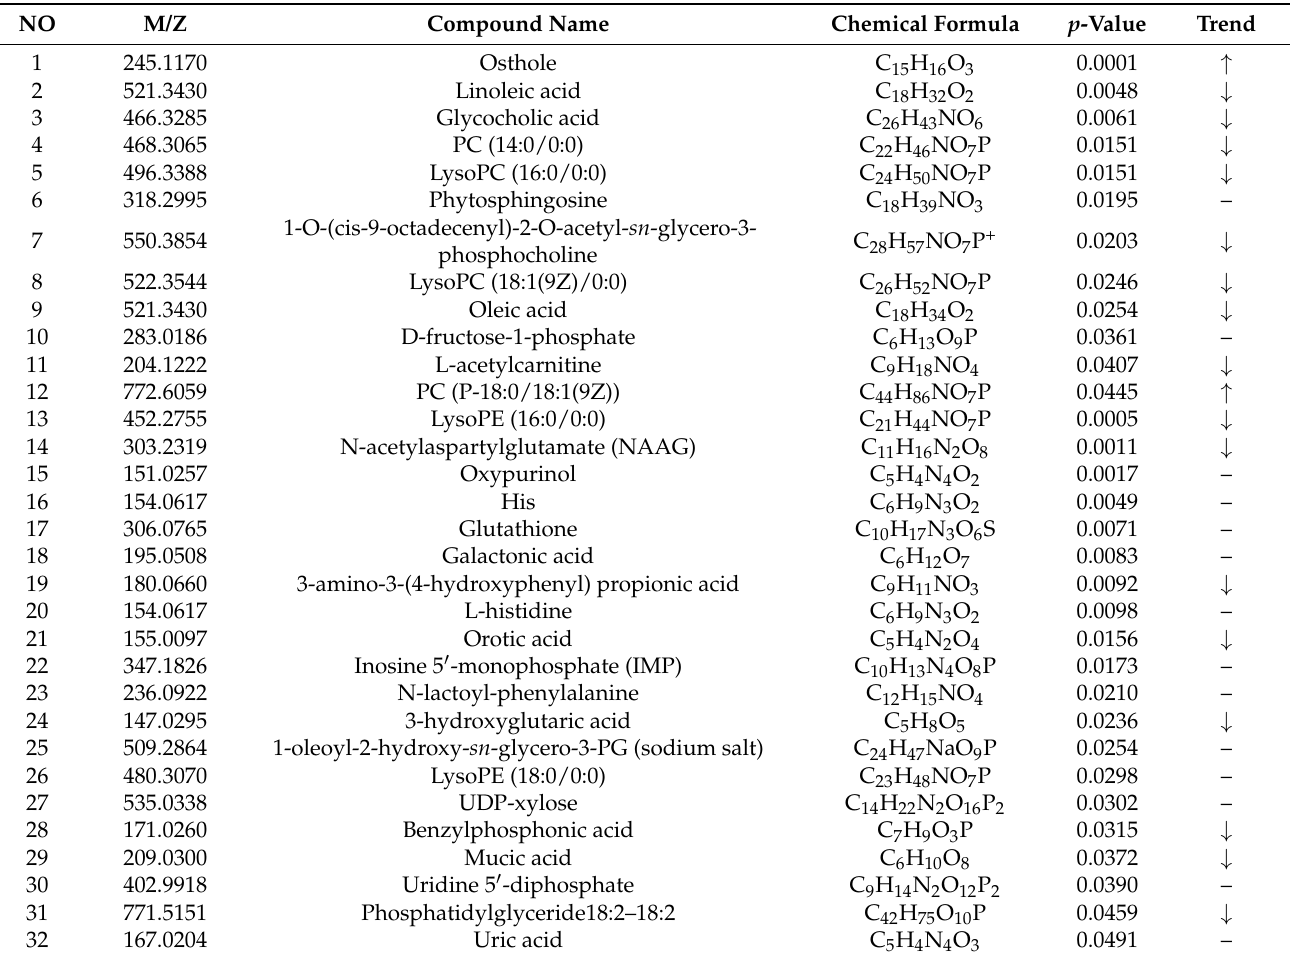
Table 1. Altered metabolites of 4T1 cells after osthole (OST) treatment in both electrospray ionization- positive (ESI + ) and ESI −